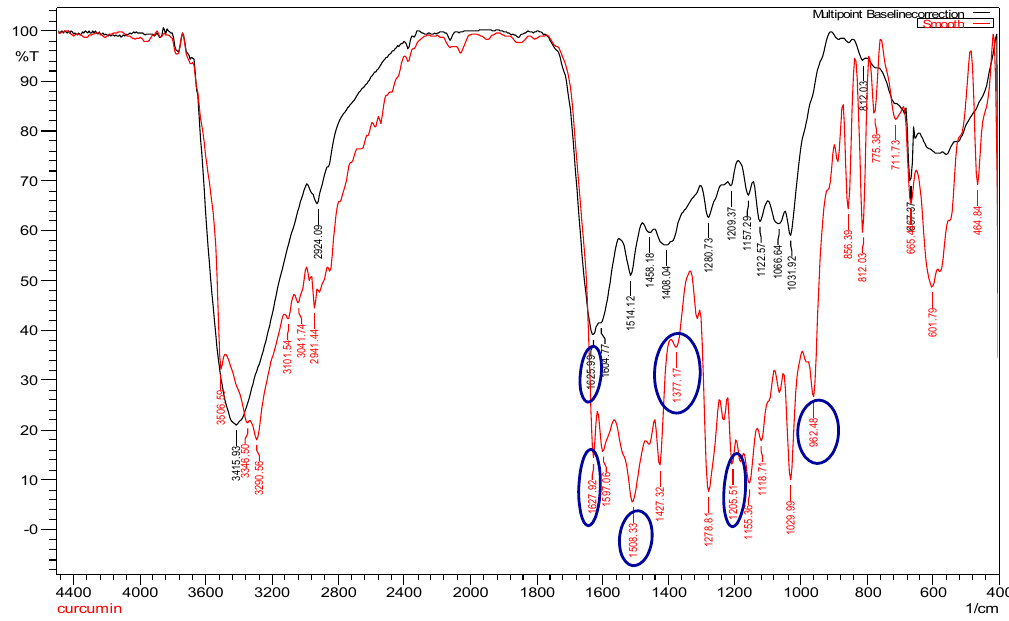
(Figure 3; red line). After the stabilization of gold nanoparticles by curcumin, there is a shift in C=O peak at 1625.99 cm − 1 appearing as a broad band, towards a higher frequency (Figure 3; black line).